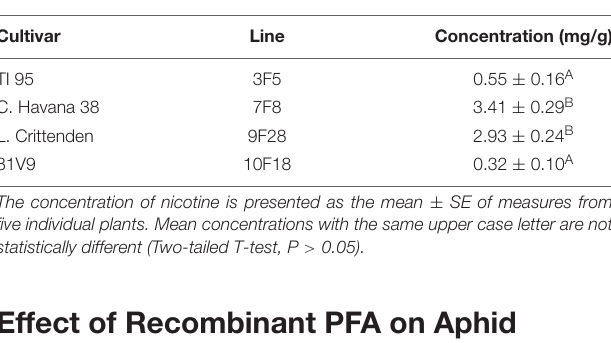
TABLE 3 | Nicotine concentration (mg/g) of greenhouse-grown tobacco